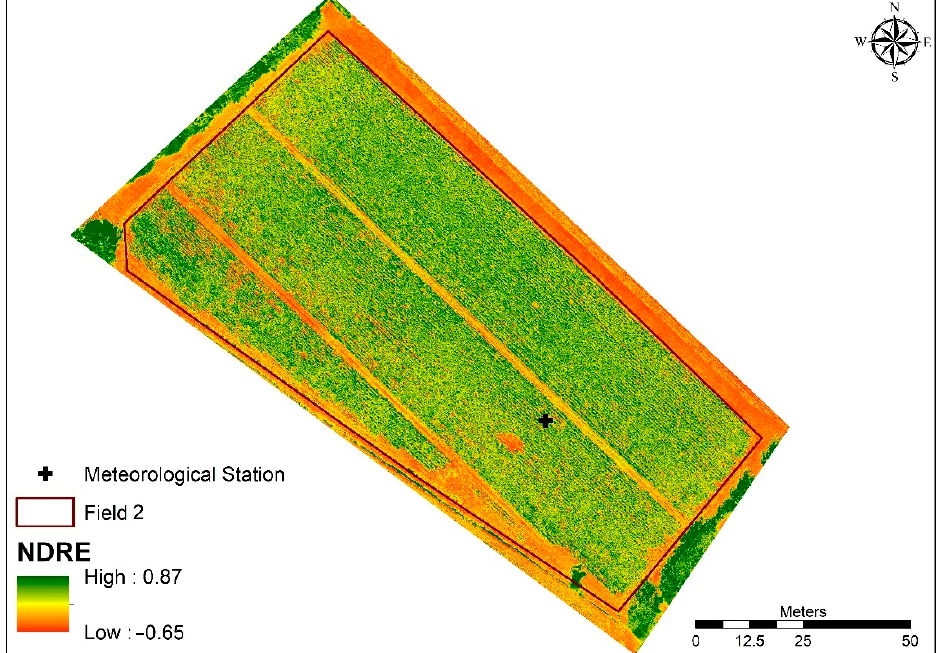
Figure 14. The red-edge normalized difference vegetation index of field 2, which was calculated using the multispectral camera data.